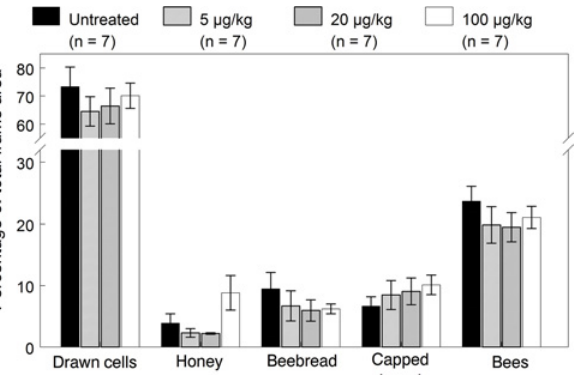
Fig 6. Colony performance endpoints of the 2010 colonies exposed for 12 weeks to untreated or imidacloprid-spiked diet patties. Means ( ± SE) are given for each endpoint recorded at the end of exposure (August 19).